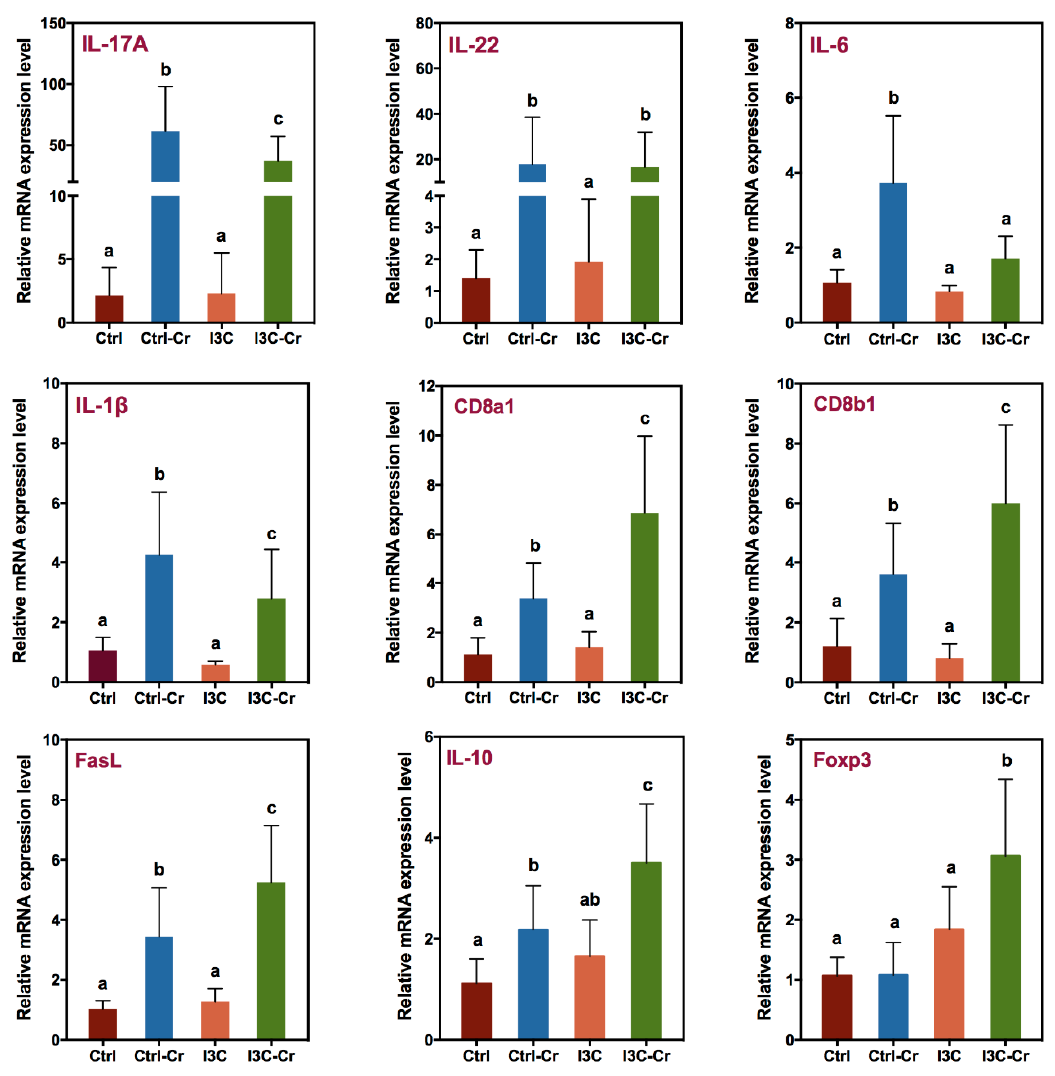
Figure 5. Effect of dietary I3C on Cr -infection-induced inflammation and immune cell markers gene expression in colon. RT-PCR was performed on total RNA isolated from colon tissues harvested on day 12 post infection. Results are expressed as the mean+/-SD fold-change ( n = 8). Groups with different letters are significantly different. ( p < 0.05) .